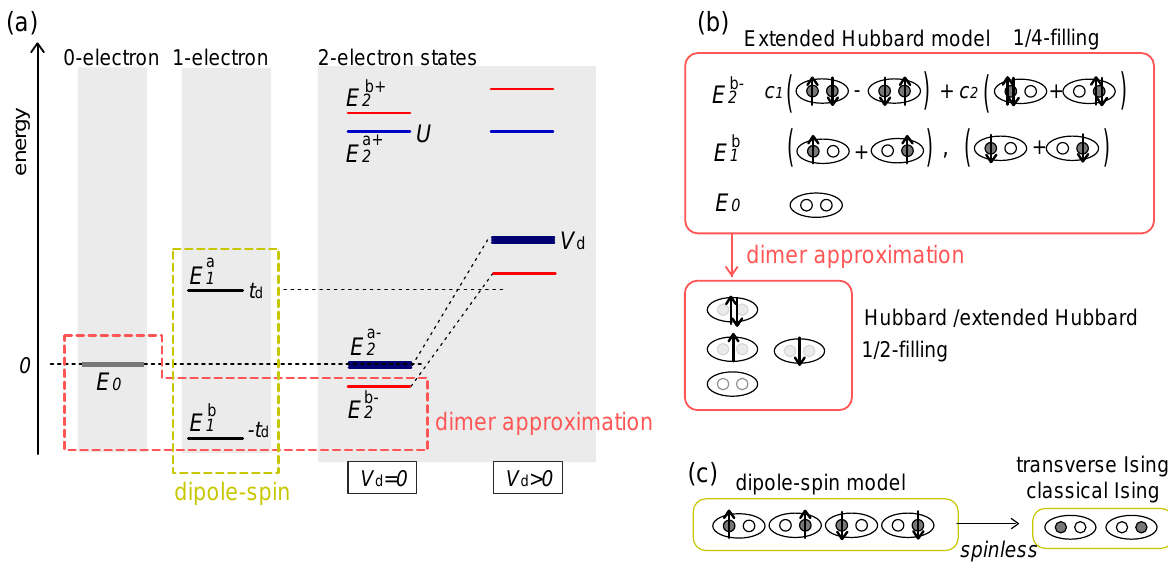
= 0 ), one ( E a/b = ± t Figure 4. ( a ) Energy levels of zero ( E ), and two electron states 0 d 1 E a ± /b ± in the isolated dimer with U (cid:29) V and t . The approximation to the half-filled d d 2 Hubbard model (dimer approximation) corresponds to confining the basis of a dimer to , E b − , E b . The dipole-spin model is verified in cases where all the those belonging to E 0 2 1 two electron levels, E a ± /b ± , become higher than E a/b . Schematic illustration of the basis 2 1 sets of the two approximations are shown in ( b ) and ( c